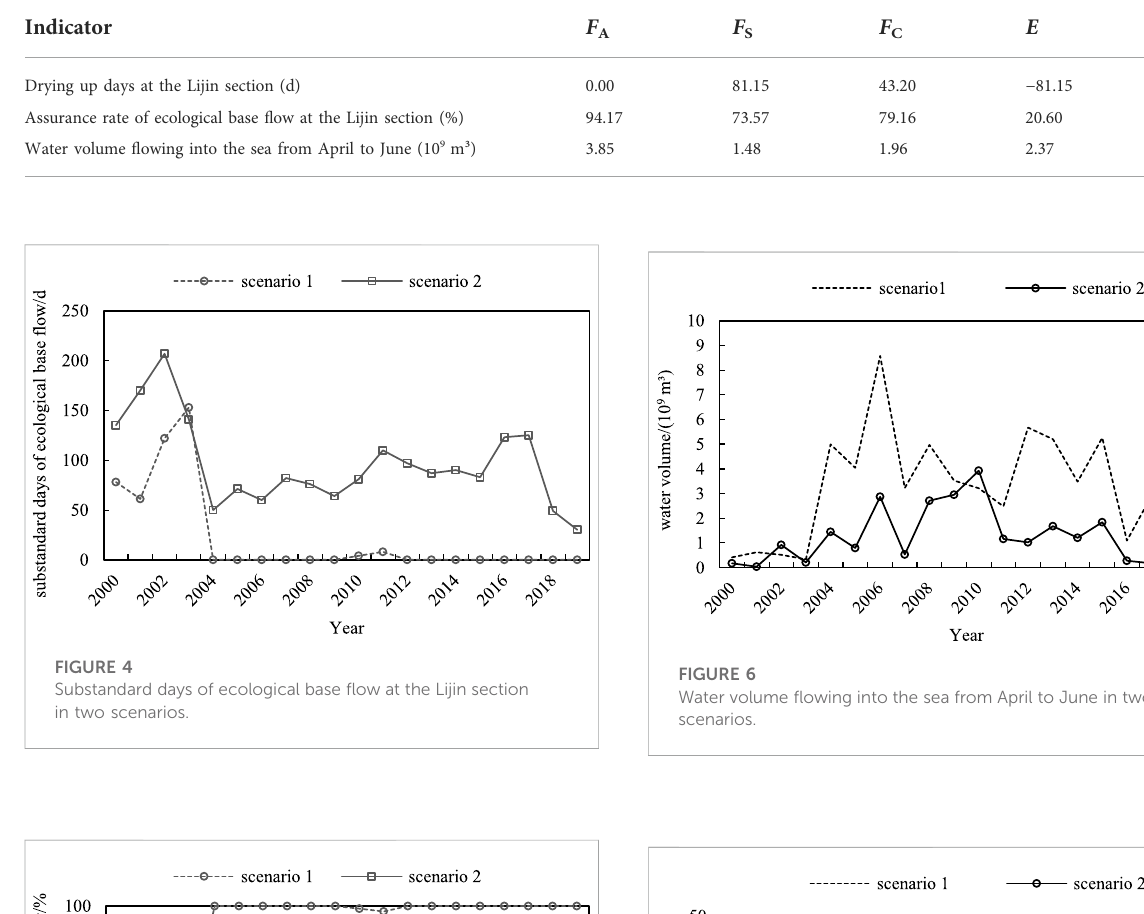
TABLE 3 Ecological index values and their changes in two scenarios.